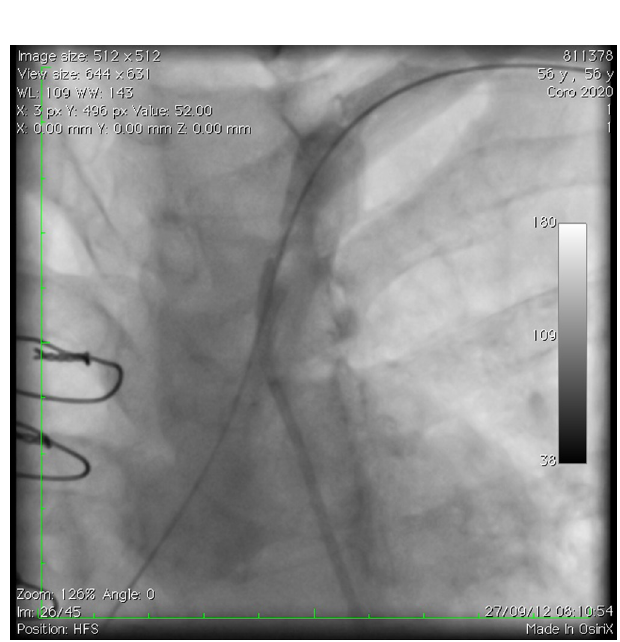
Fig. 2 - Proximal and distal access to the lesion access and facilitating overtaking angiographic control